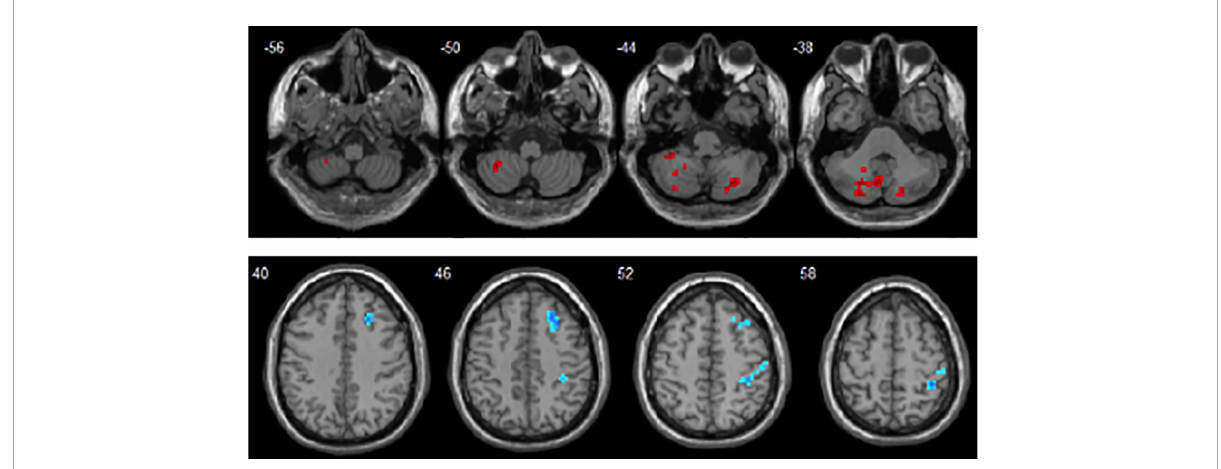
FIGURE1 Brain areas with significant dReHo differences between autism spectrum disorder (ASD) and language development delay (LDD) groups. Regions in red-yellow are brain areas where dReHo was significantly increased in ASD compared to LDD. Regions in blue-green are brain areas where dReHo was significantly decreased in ASD compared to LDD. The results were multiple compared at the voxel-level ( P < 0.05, FDR corrected). The left side of the image corresponds to the left hemisphere of the brain.